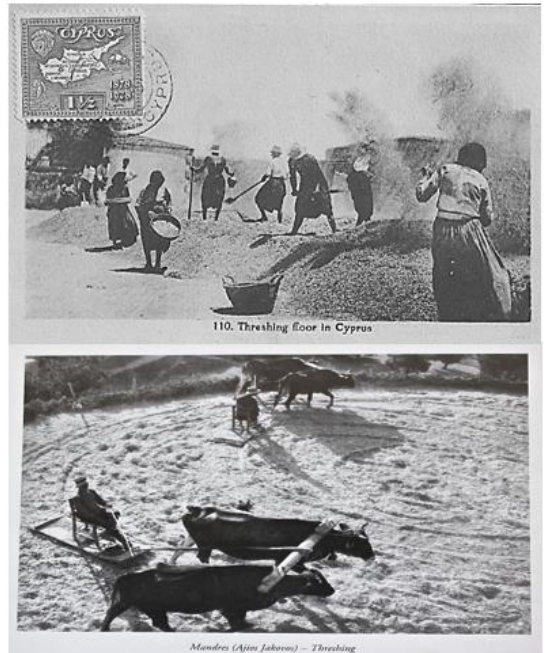
Figure 1 . Old Postal Cards depicting scenes during threshing and winnowing process in Cyprus during 30s.